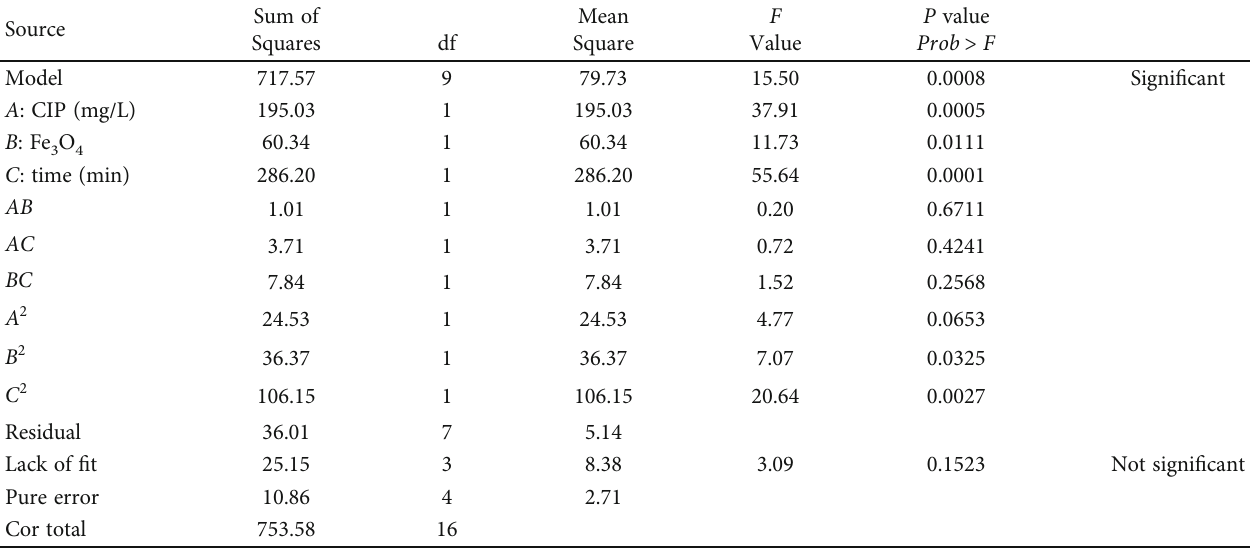
Table 3: Results of analysis of variance (ANOVA).